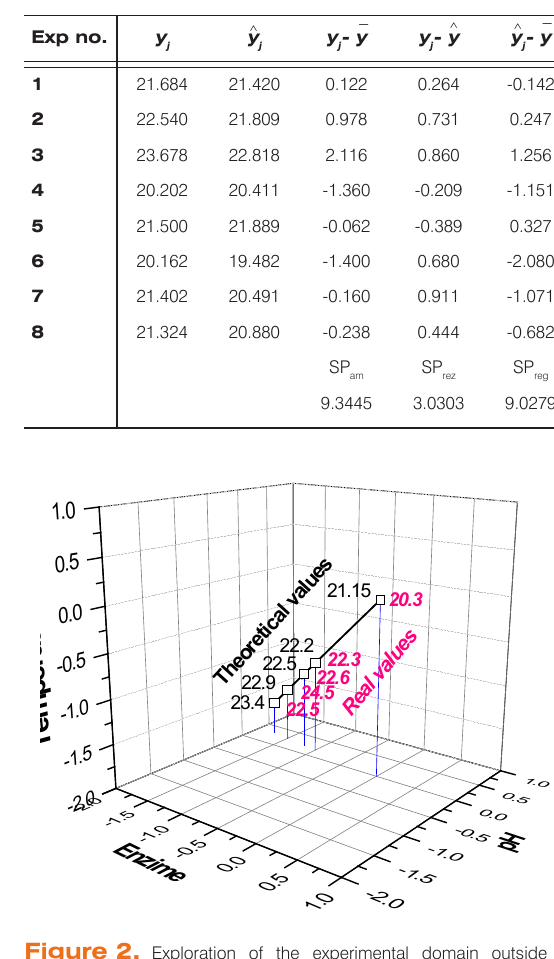
Figure 2. Exploration of the experimental domain outside of the initial domain of the variation of the variables. Experimental points and theoretical and practical values of the essential oil